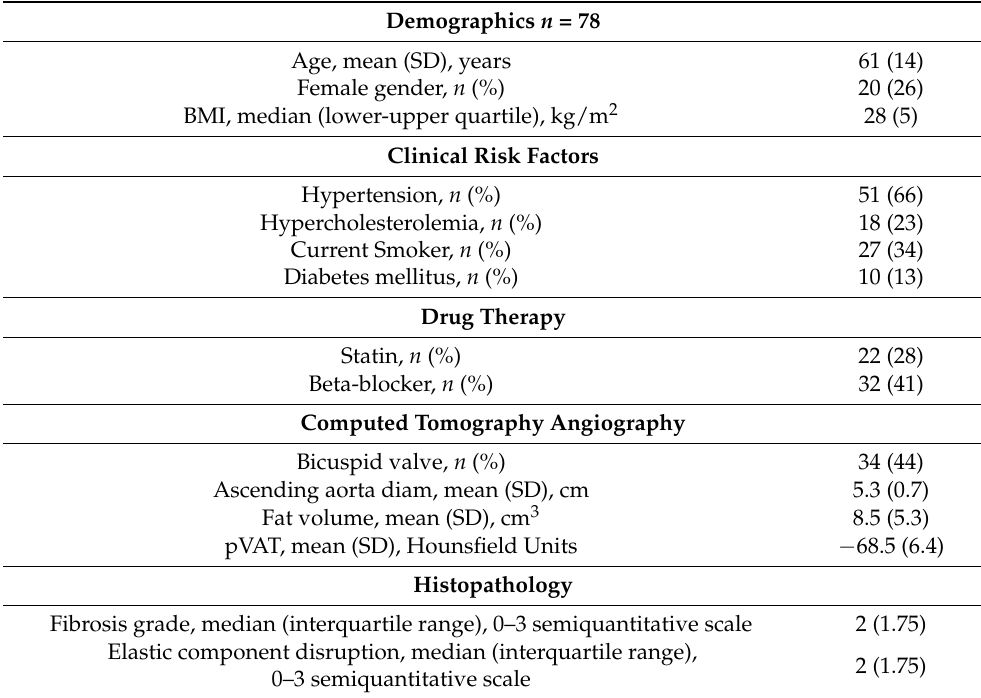
Table 1. Demographic, clinical, and main CTA and histopathology characteristics of the study